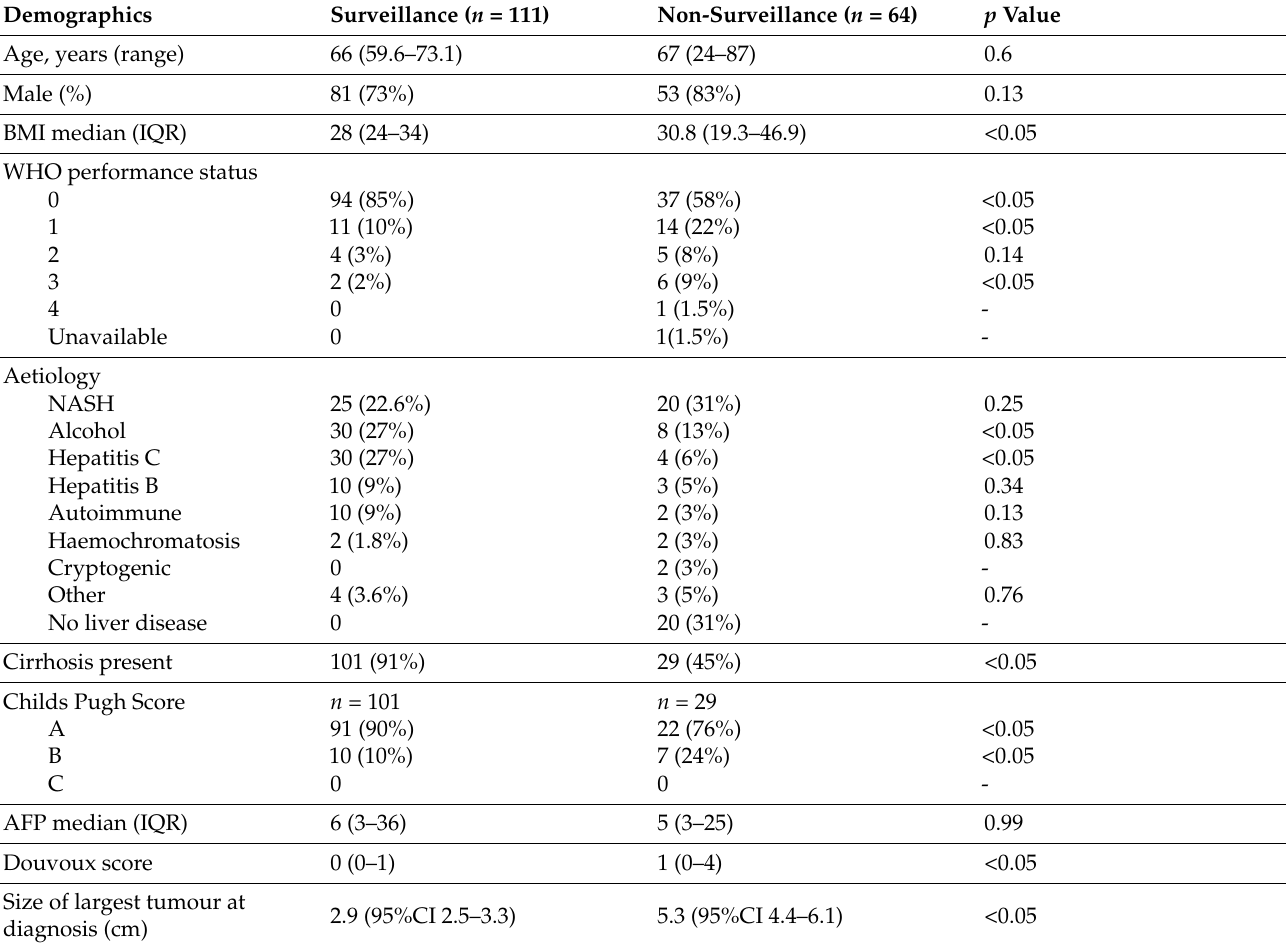
Table 1. Patient and tumour demographics in surveillance and non-surveillance